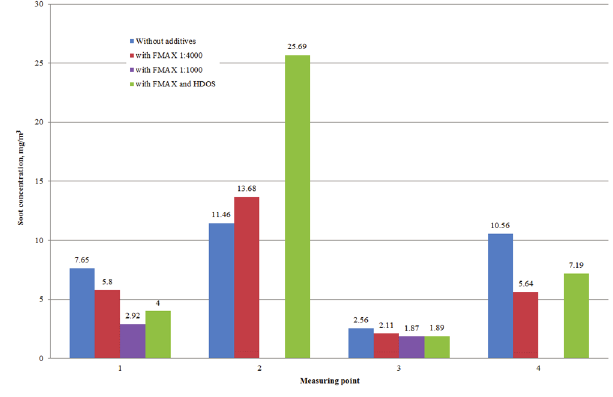
Fig. 4. Concentrations of soot measured in tests